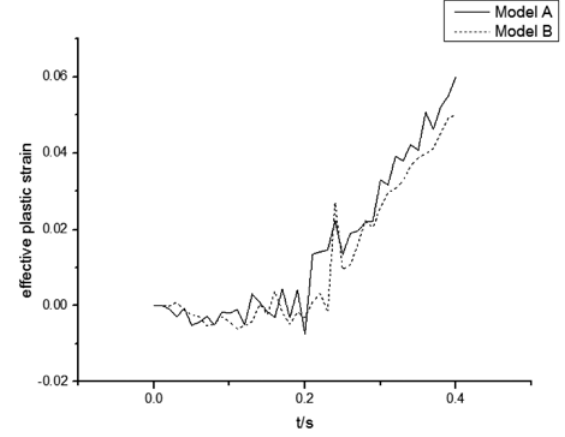
Fig. 11. Equivalent stress variation of the element in the fold The element size contrast of the distorted element with and without correction is shown in (Fig. 12). For the uncorrected model A, the element error of the outer layer is 9% and the inner layer is –23.8%. For the cor- rected model B, the element error of the inner and outer layer is 0.75% and 0.25%, respectively. It is evident that the accuracy is greatly increased.